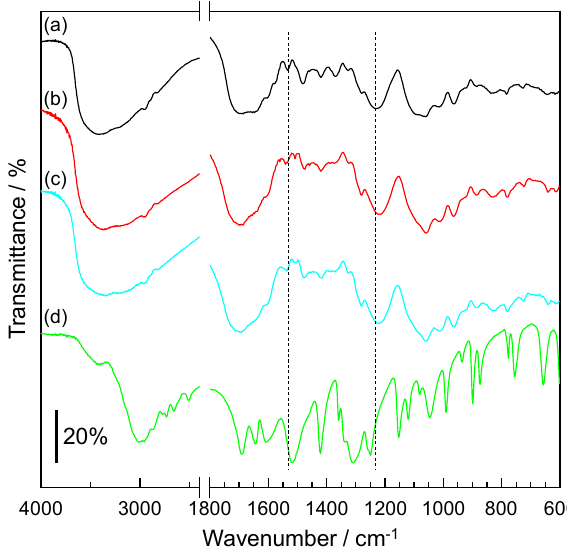
Figure 2. IR spectra of: (a) UV-irradiated DNA film; (b) L-Asp accumulated DNA film; (c) D-Asp accumulated DNA film; and (d) L-Asp. Amino acid-accumulated DNA film was prepared by the immersion of the UV-irradiated DNA into an aqueous amino acid solution. Triplicate experiments gave similar results.